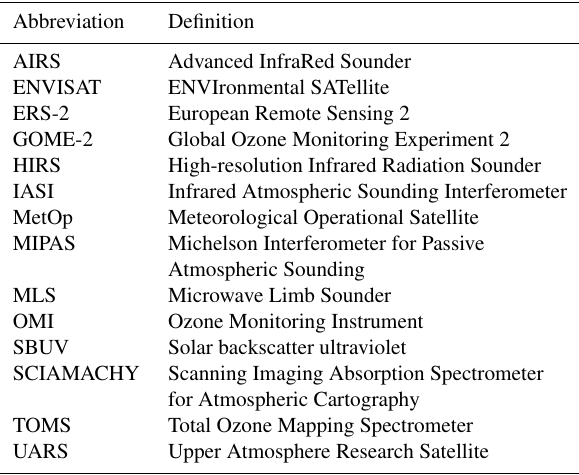
Table 2. List of all other abbreviations used in this paper and not defined in the